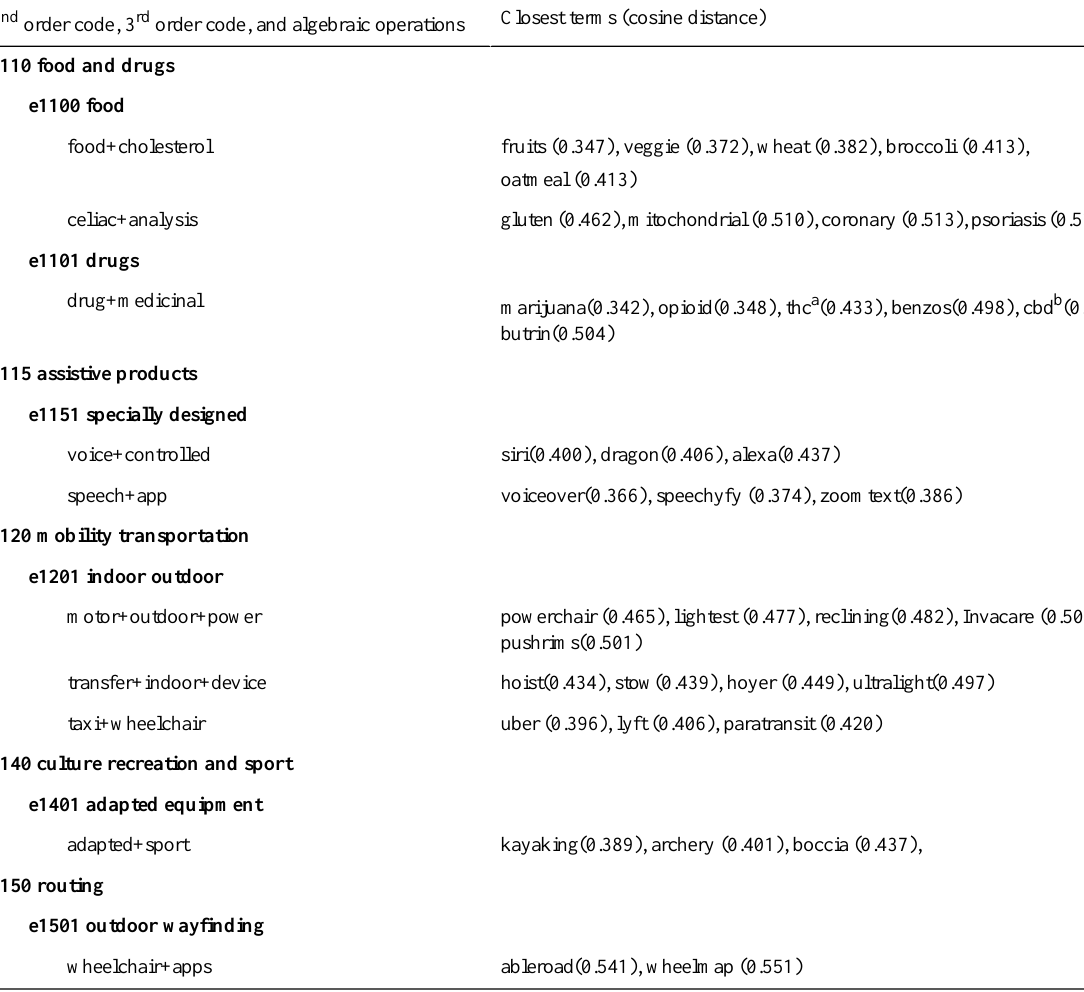
Table 1. Products and technology